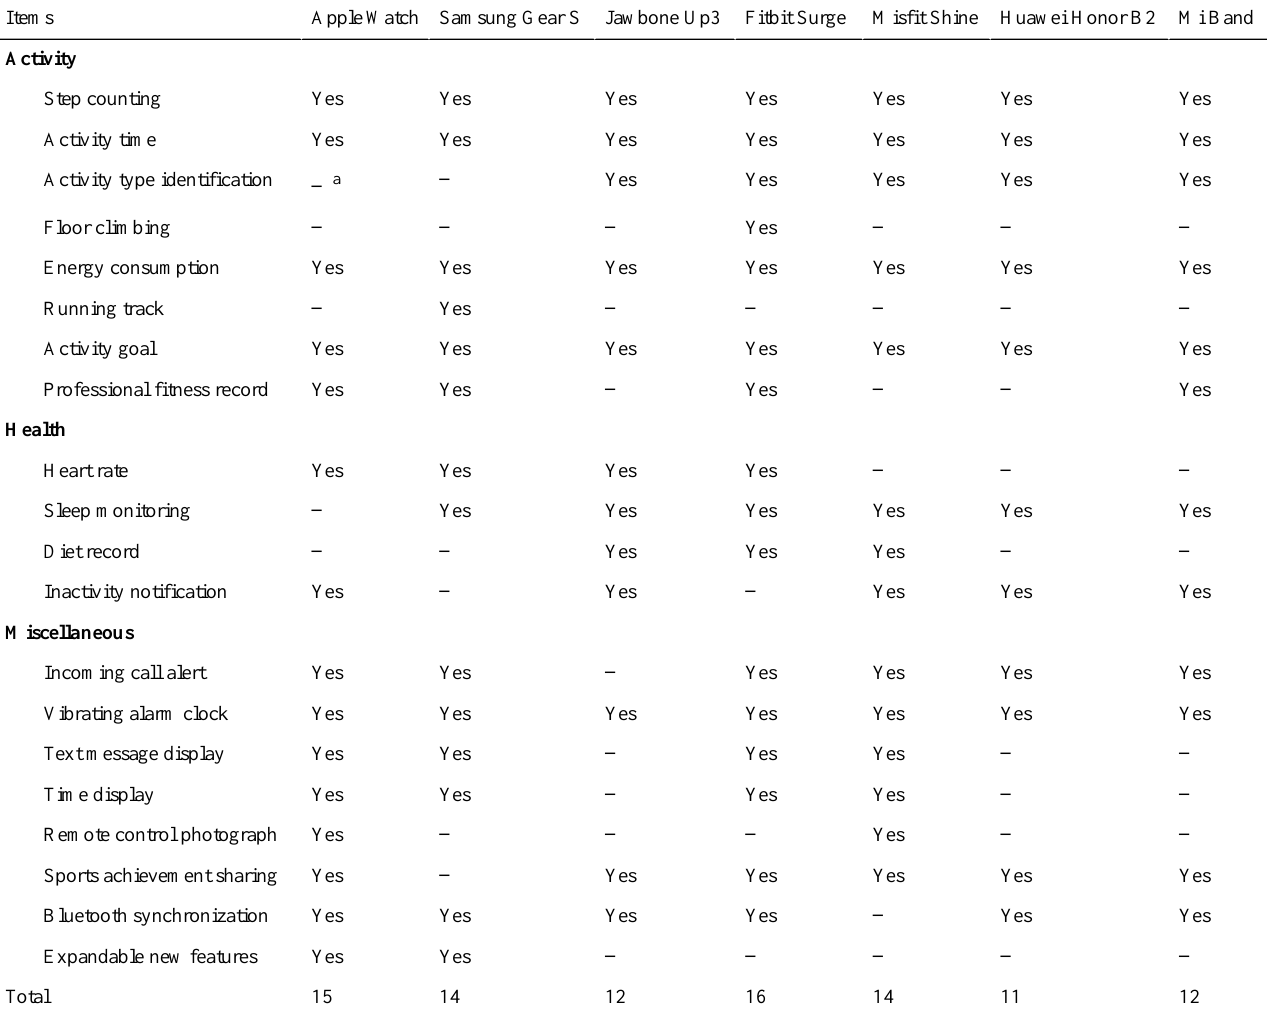
Table 1. Function summary of the seven wearable devices.